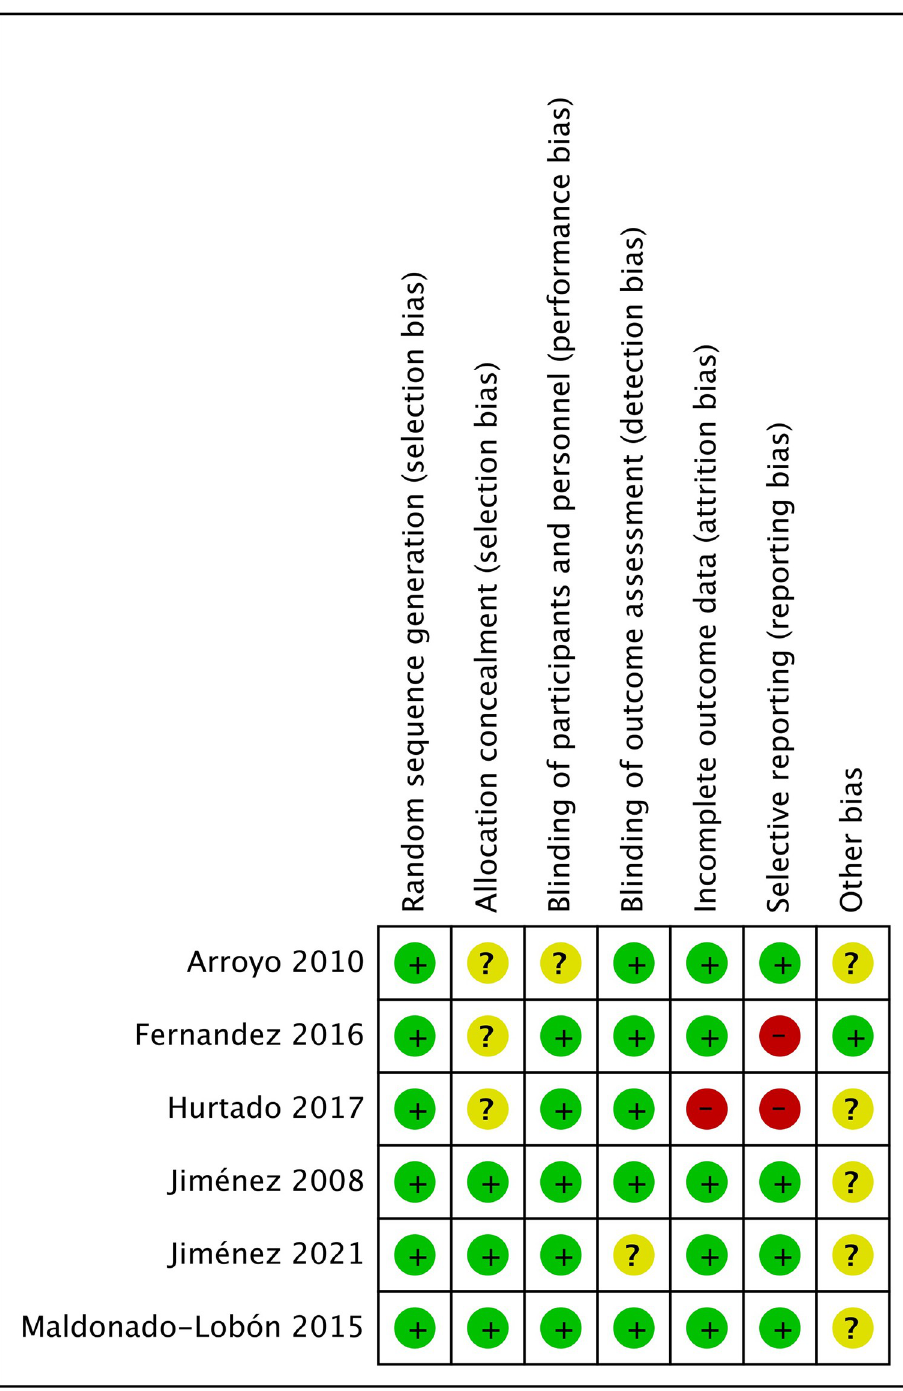
Fig 3. Risk of bias summary: Review authors’ judgments about each risk of bias item for all included studies.